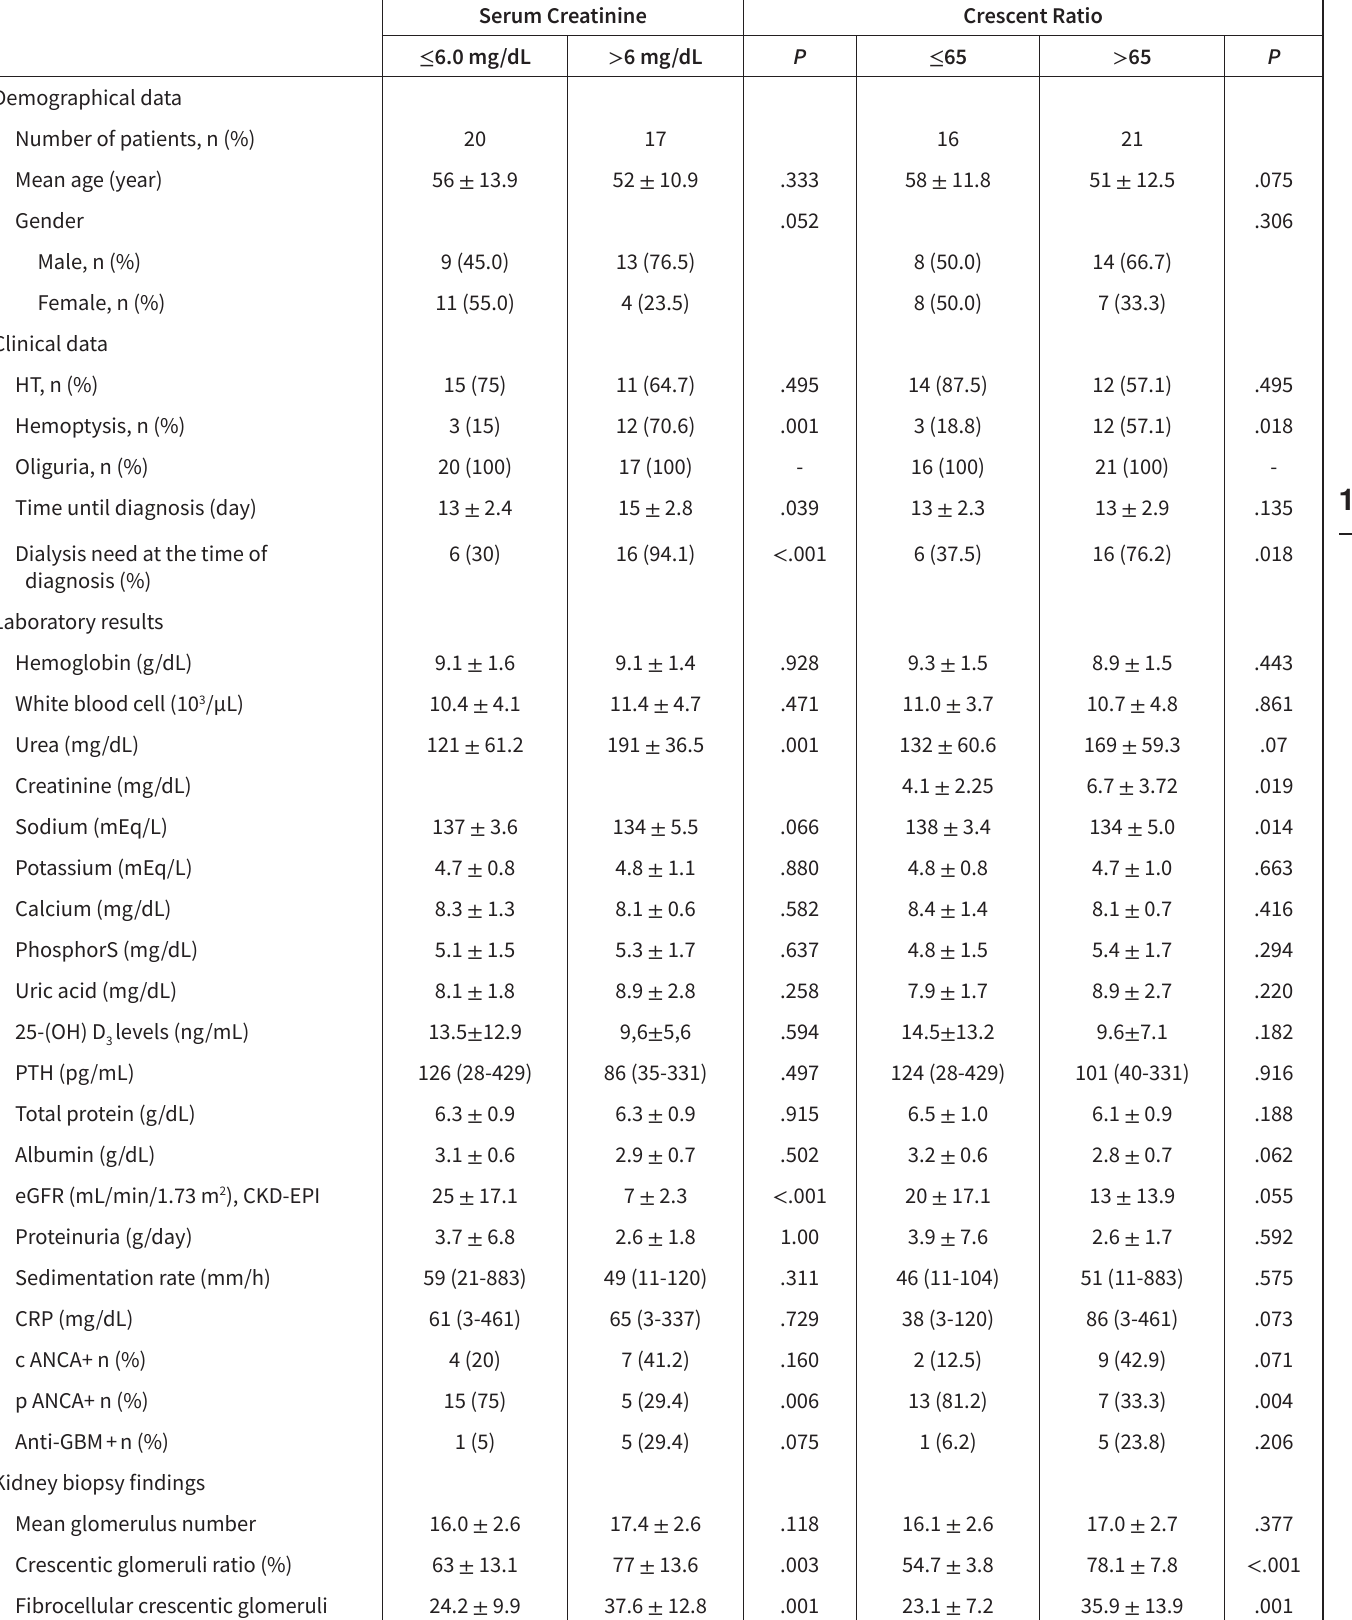
Table 2. Comparison of Patients According to Serum Creatinine Values and Crescentic Glomerule Ratios at the Time of Admission Serum Creatinine Crescent Ratio ≤ 6.0 mg/dL > 6 mg/dL P ≤ 65 > 65